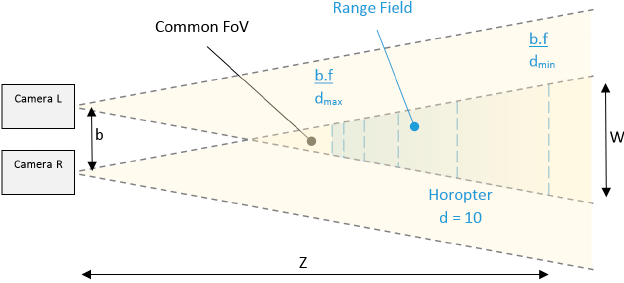
Figure 1. Top view of a conventional stereo vision system. Detail of the Range Field including the boundary of depth triangulation range adopted at the Horopter of 10 disparities.